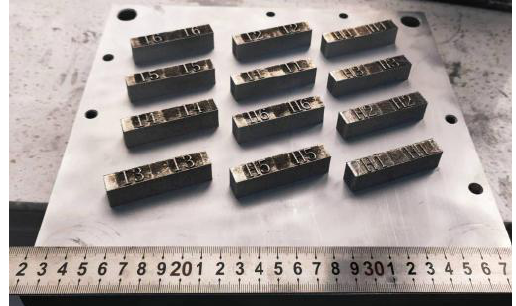
Figure 2. SLM formed samples.